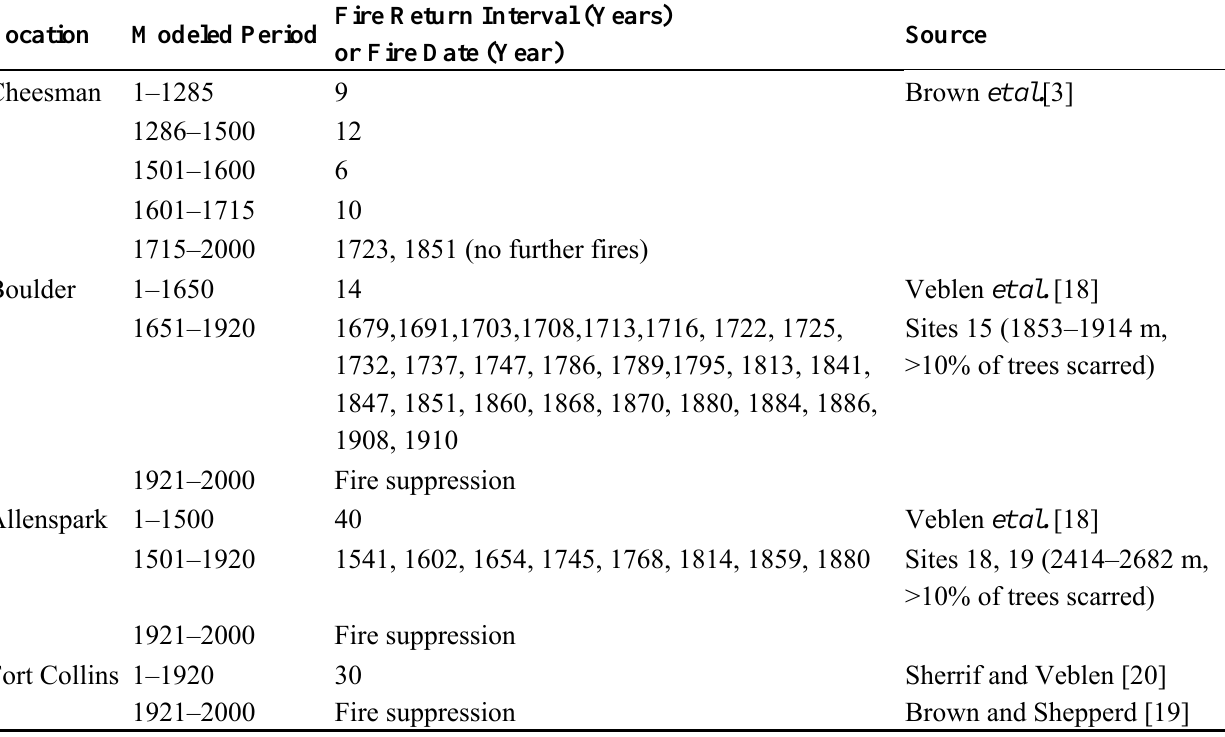
Table 2. Time period(s) modeled using DAYCENT, including fire return intervals (years) or fire dates (year A.D.) for a particular time period at a specific site. Fire record data for each of these sites were retrieved from the literature source cited. These data were coded into the DAYCENT schedule file (*.sch) to reflect the same event chronology as that site had experienced in the